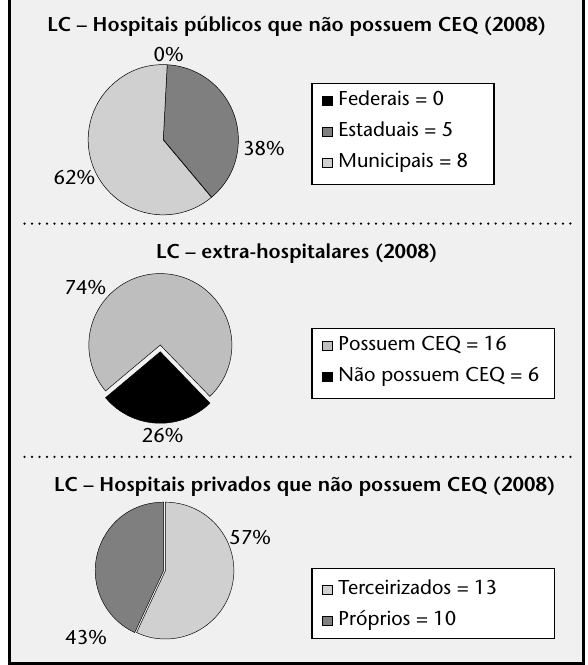
Figura 3 – Total de LCs (ano 2008) que não possuíam CEQ = 42 LC: laboratório clínico; CEQ: controle externo de